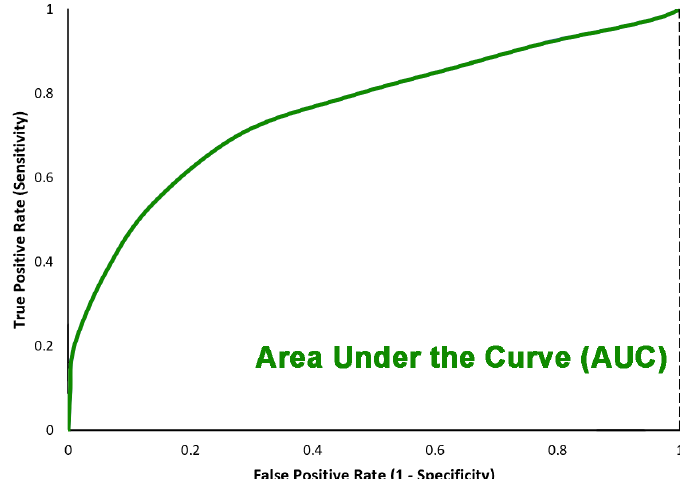
Figure 9. Area under the curve.